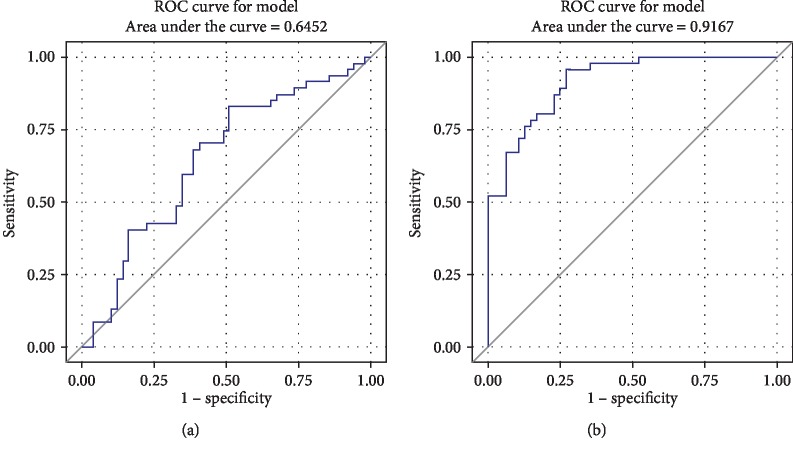
Receiver operating curve (ROC) analysis showed that Ang II alone can discriminate control and NAFLD patients where the area under curve (AUC) was 0.6452 (a) and, especially when Ang II was combined with body weight, TG, and serum insulin which are shown in Table 2, the AUC was 0.9167 (b), suggesting that Ang II was an important factor associated with NAFLD.